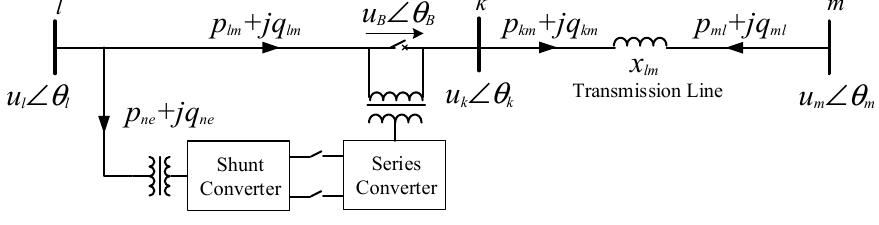
Figure 1. Schematic diagram of the UPFC-embedded line.